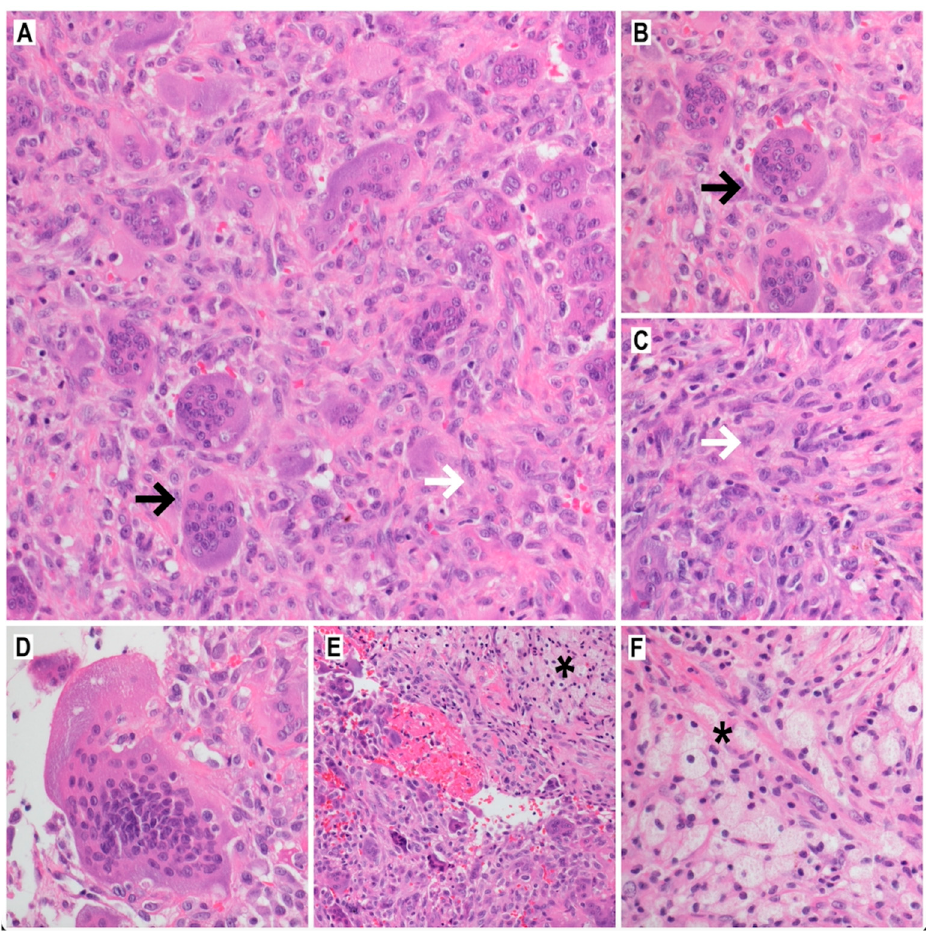
Figure 2. Giant cell tumor of bone: the characteristic mixture of osteoclast ‐ like giant cells ( A , black arrow, HE, 200×; B , black arrow, HE, 400×), and mononuclear neoplastic cells ( A , white arrow, HE, arrow, HE, 200 × ; B , black arrow, HE, 400 × ), and mononuclear neoplastic cells ( A , white arrow, HE, 200×; C , white arrow, HE, 400×); some of the giant ‐ cells have >50 nuclei per cell ( D , HE, 600×); 200 × ; C , white arrow, HE, 400 × ); some of the giant-cells have >50 nuclei per cell ( D , HE, 600 × ); hemorrhages ( E , HE, 200×), and field of foamy macrophages ( E , arteriks, HE, 200×; F , arteriks, HE, hemorrhages ( E , HE, 200 × ), and field of foamy macrophages ( E , arteriks, HE, 200 × ; F , arteriks, HE, 400×;) are present in majority of cases. 400 × ) are present in majority of